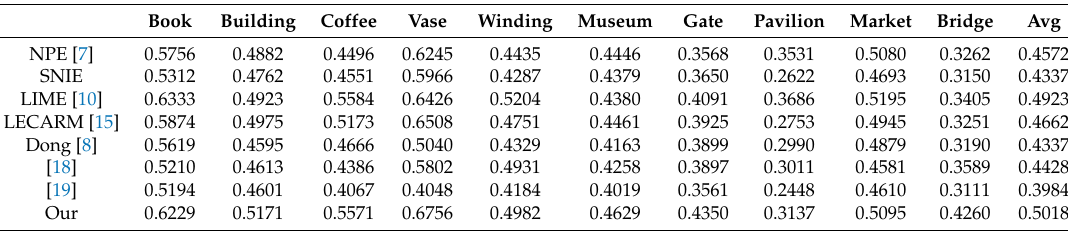
Table 1. PCQI of eight different algorithms.